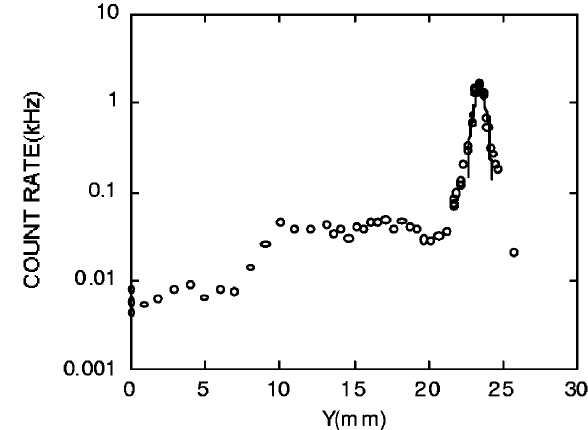
FIG. 2. Vertical profile of the extracted beam taken with a thin finger counter. Note the tail extending below the main peak. The solid line is a Gaussian fit to the data in the peak